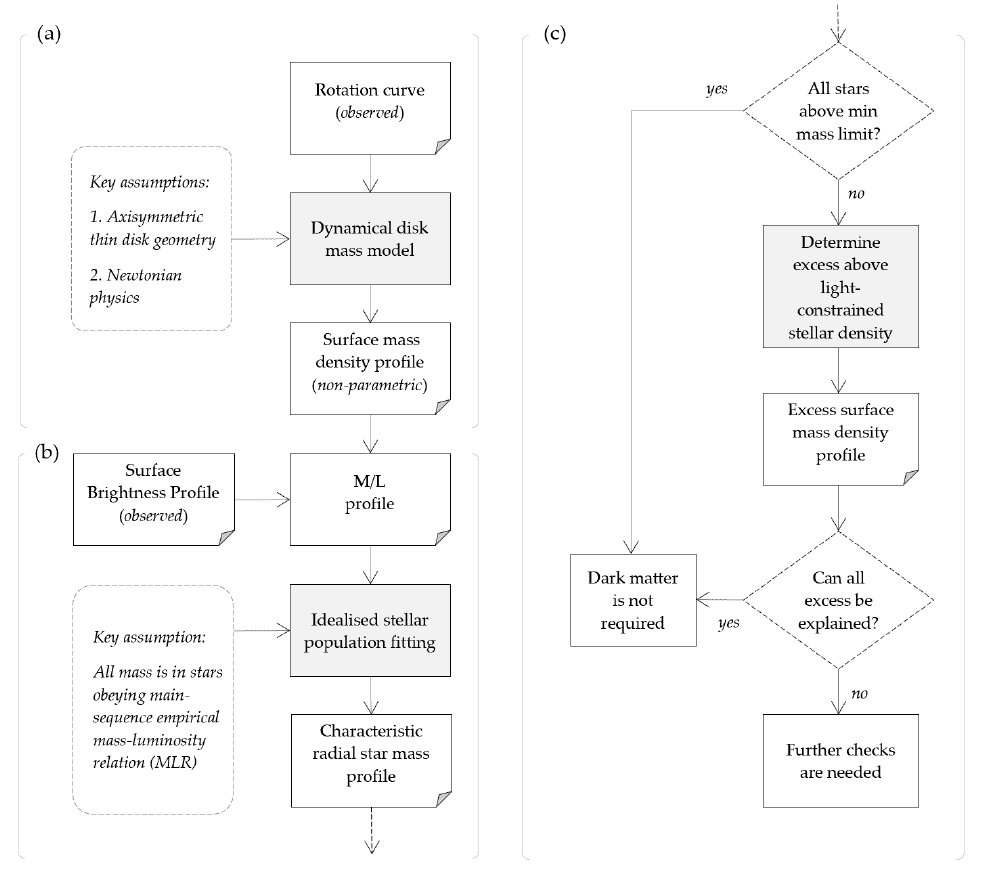
Figure 3 recaps the key points of our analytical framework in a flowchart format.